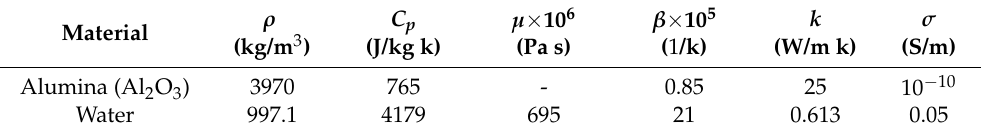
Table 1. Thermophysical characteristics at 293 K [41] and